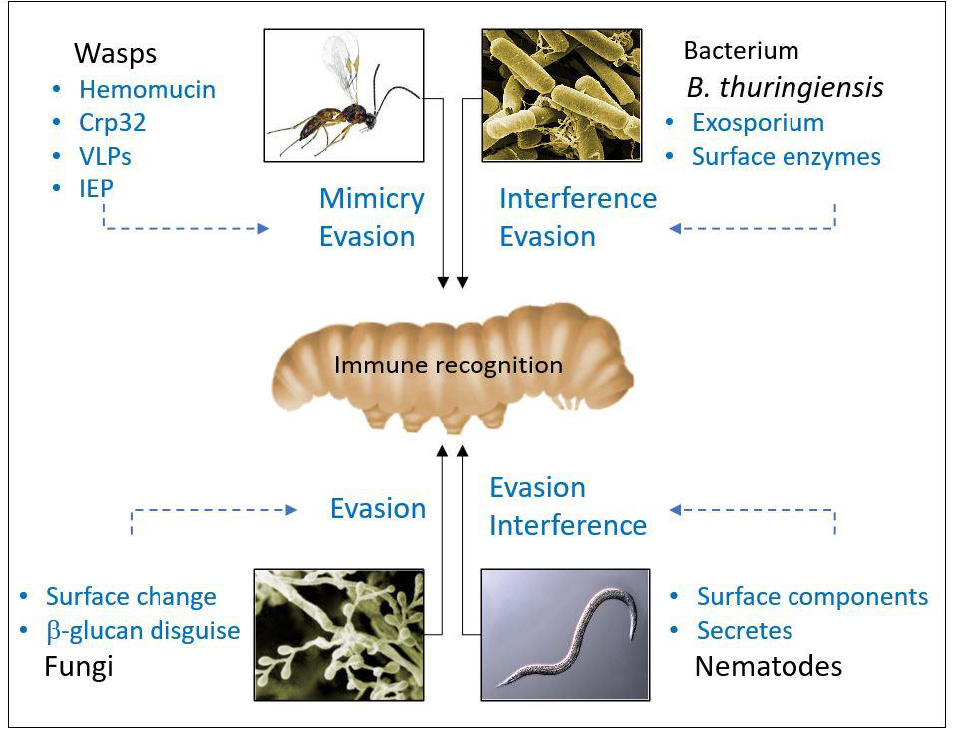
Figure 11. A schematic of the role of compounds at the surface of entomopathogens.